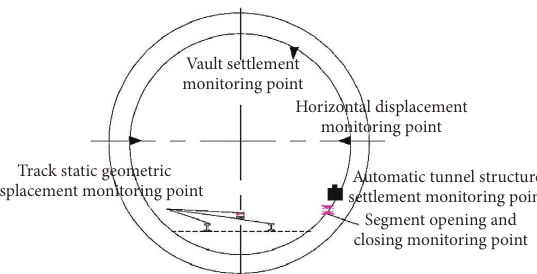
Figure 6: Layout of monitoring points of existing